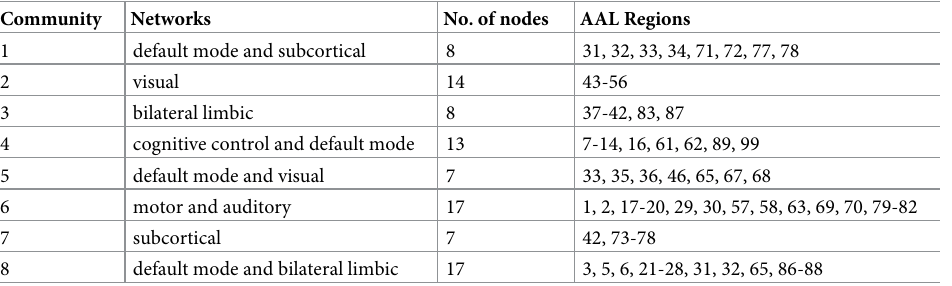
Table 1. Brain networks identified using LR-MVRC with K = 8 in NMF. Fourth column represent AAL atlas ROI indices belonging to the community K , whereas second and third columns represent the associated brain networks and number of ROIs in that community,